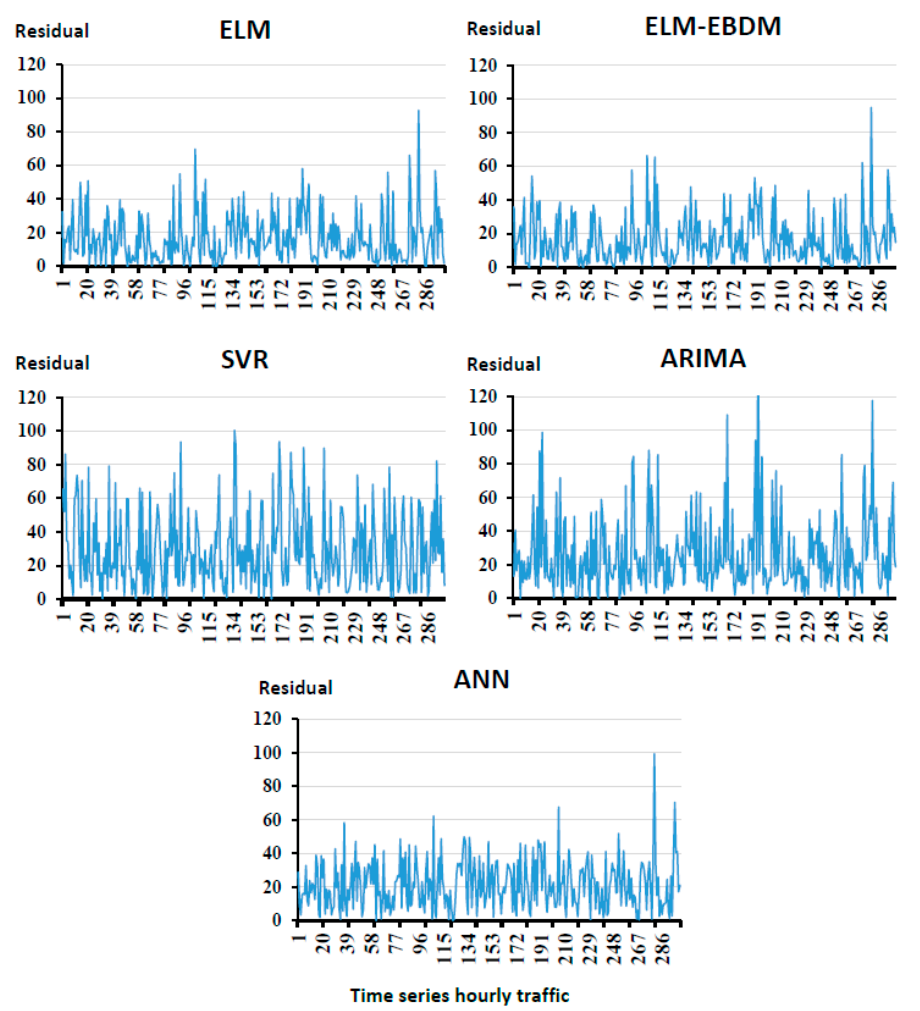
Figure 5. The absolute residual error in test phase .